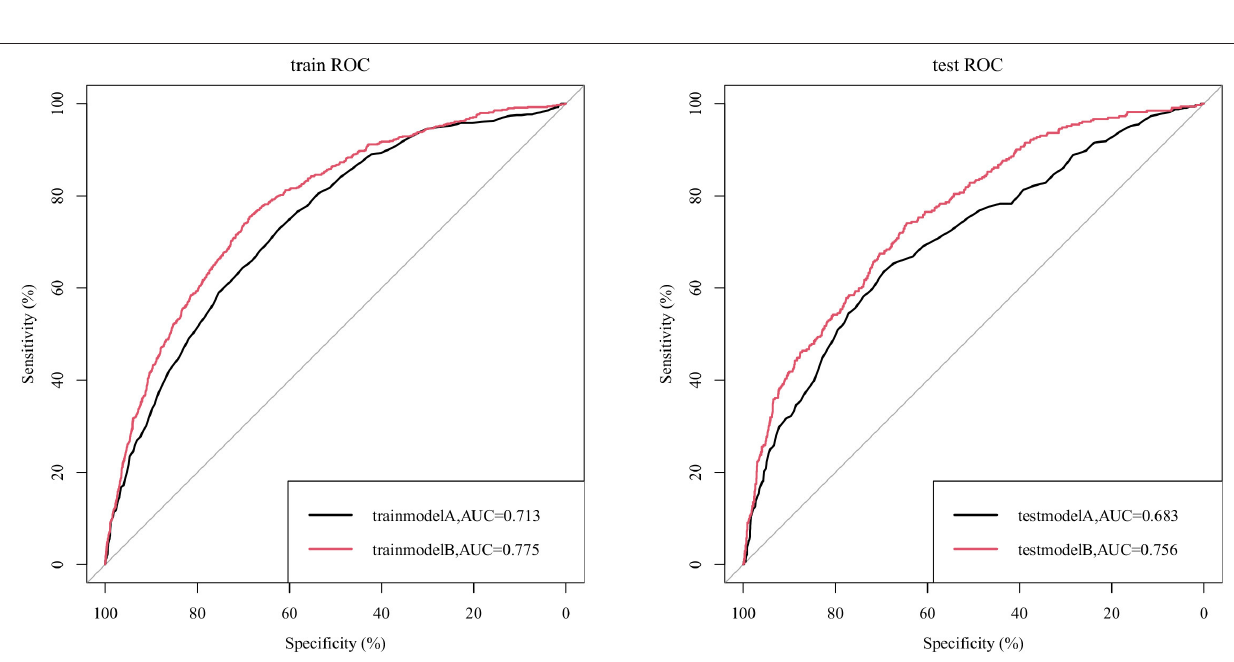
Frontiers in Medicine |